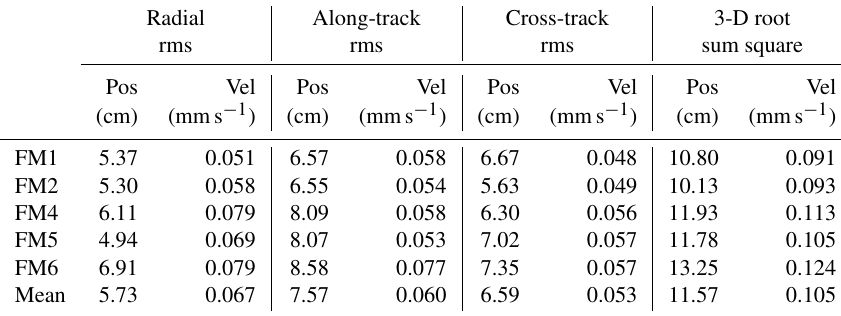
Table 2. The rms of COSMIC satellites compared with overlapping orbits on three axes. Radial Along-track